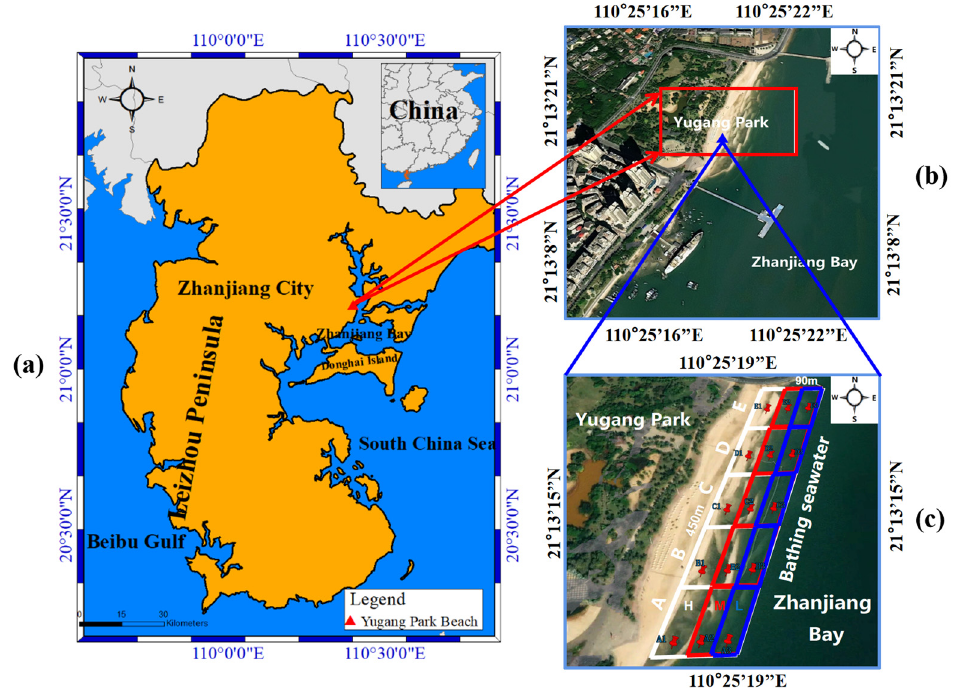
Figure 1. Geographical location of Zhanjiang Bay (ZJB) ( a ), Yugang Park Beach (YPB) ( b ), and de- tailed information of the bathing seawater sampling stations (H: high tide, M: mid tide, L: low tide) ( c ).